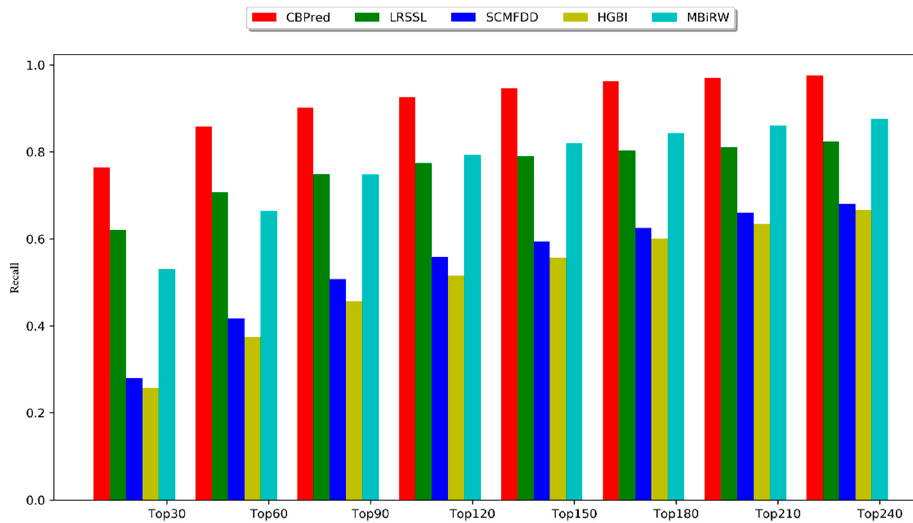
Figure 7. Top k recall rate of CBPred and other methods.